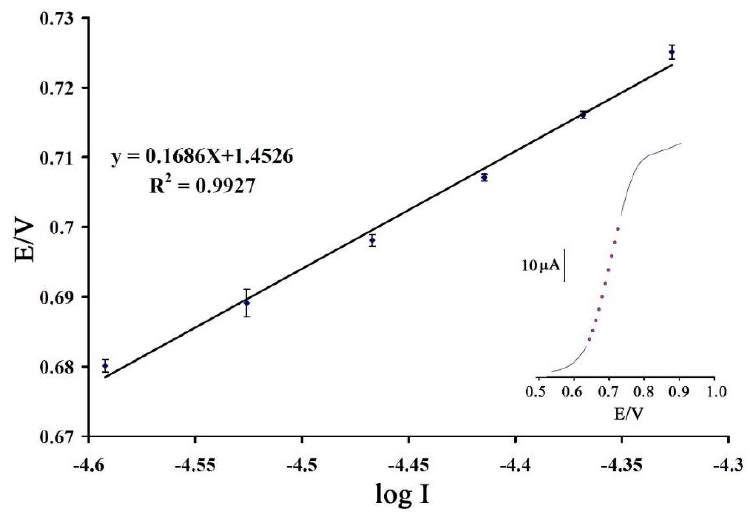
Figure 5. Tafel plot for 1,3-DIBr/ZnO/CNTs/CPE in 0.1 M PBS (pH 9.0) with a scan rate of 10 mV/s in the presence of vitamin B 9 .